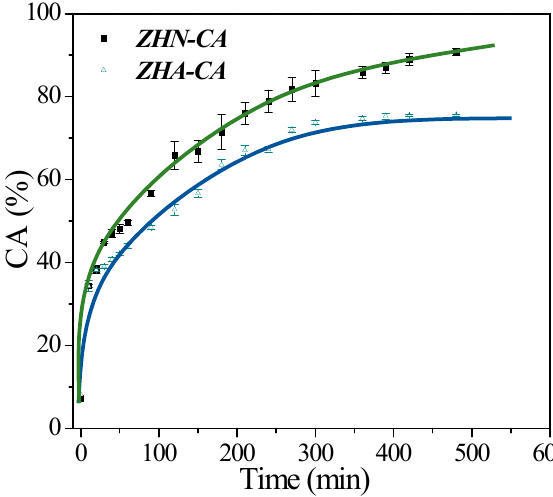
Figure 8. Release profiles for CA from ZHN–CA and ZHA–CA in buffer solutions at pH 7.1. Solid lines are a guide for the behavior of the releasing profile and have no physical significance. The curves correspond to the average of three experimental measurements for each point.